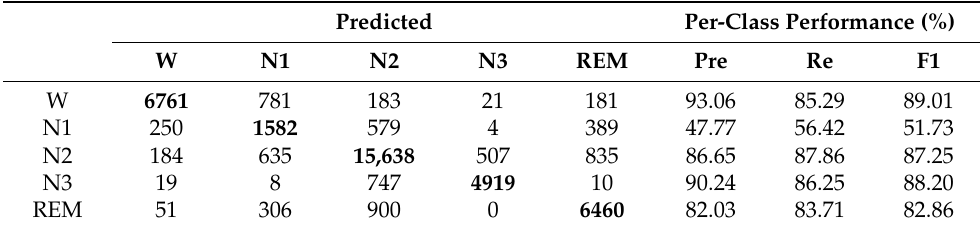
Table 2. Performance of CCRRSleepNet on Fpz-Cz channel.